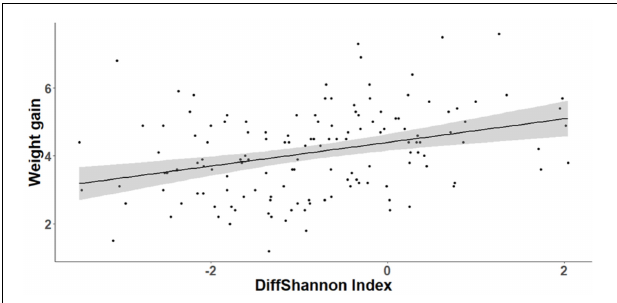
FIGURE 8 | Relationship between individual nestling weight gain and change in cloacal microbiota diversity (Shannon index) between D8 and D15. Gray area around the line refers to the 95% confident